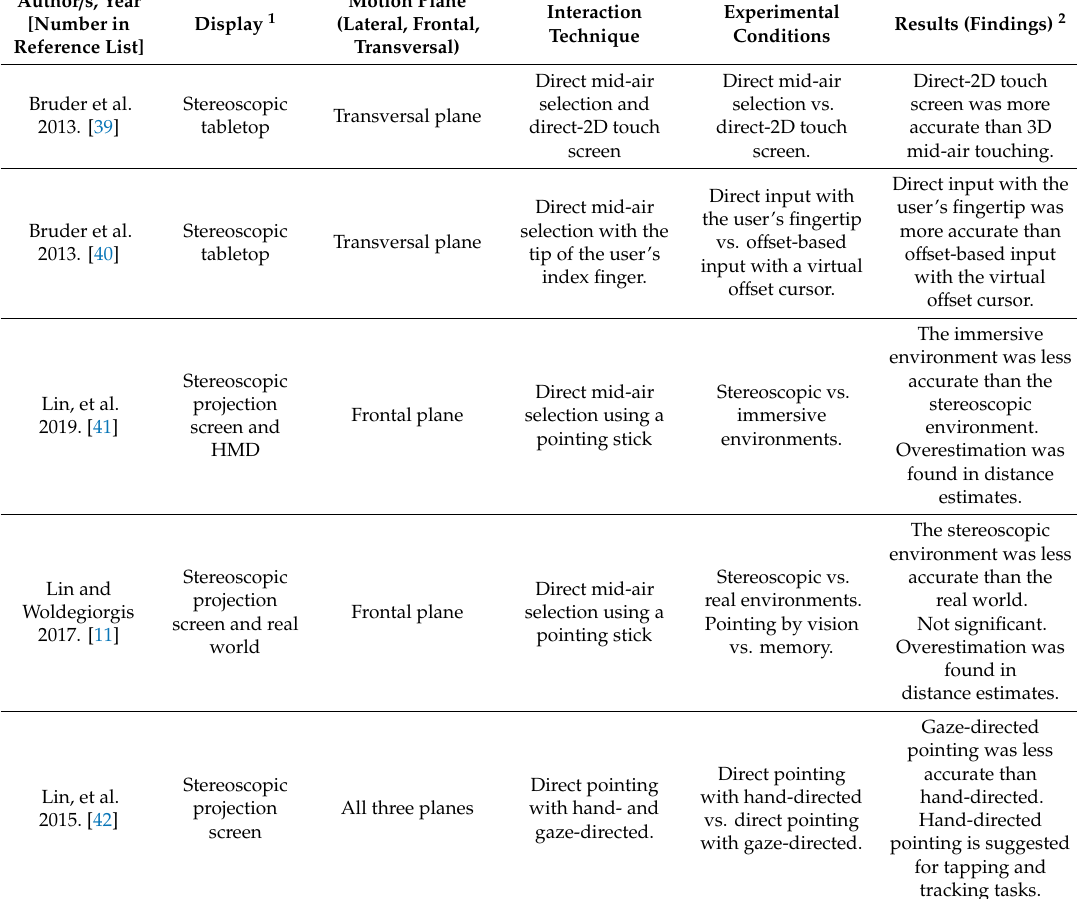
Table 1. Summary of studies on interaction techniques (direct or indirect interaction). Interaction techniques influence the accuracy of egocentric distance estimation in di ff erent displays and under various experimental